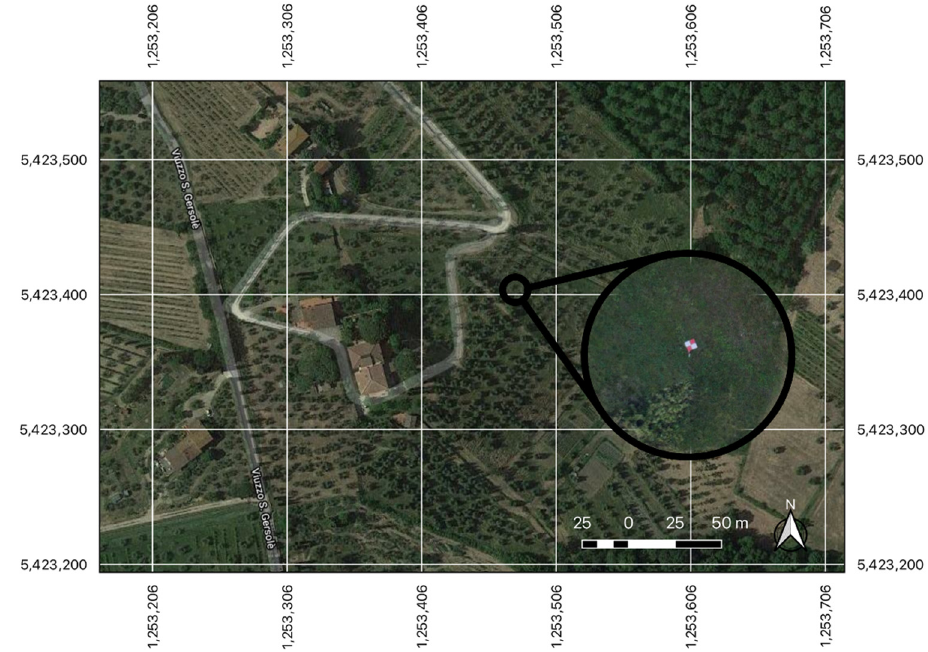
Figure 3. Orthomosaic of the surveyed area.